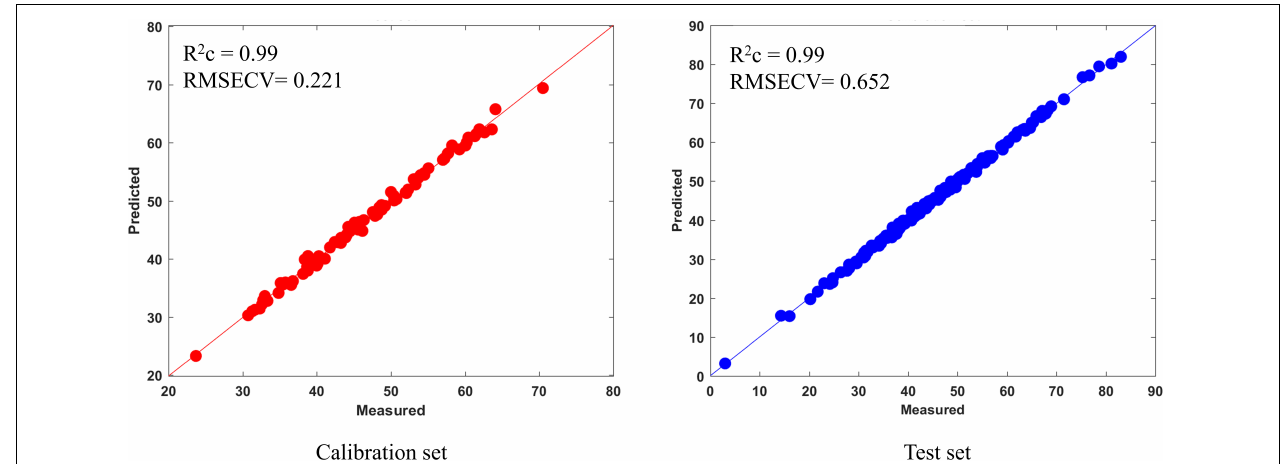
FIGURE 6 | The results of the SPORT model on the calibration set and test set.